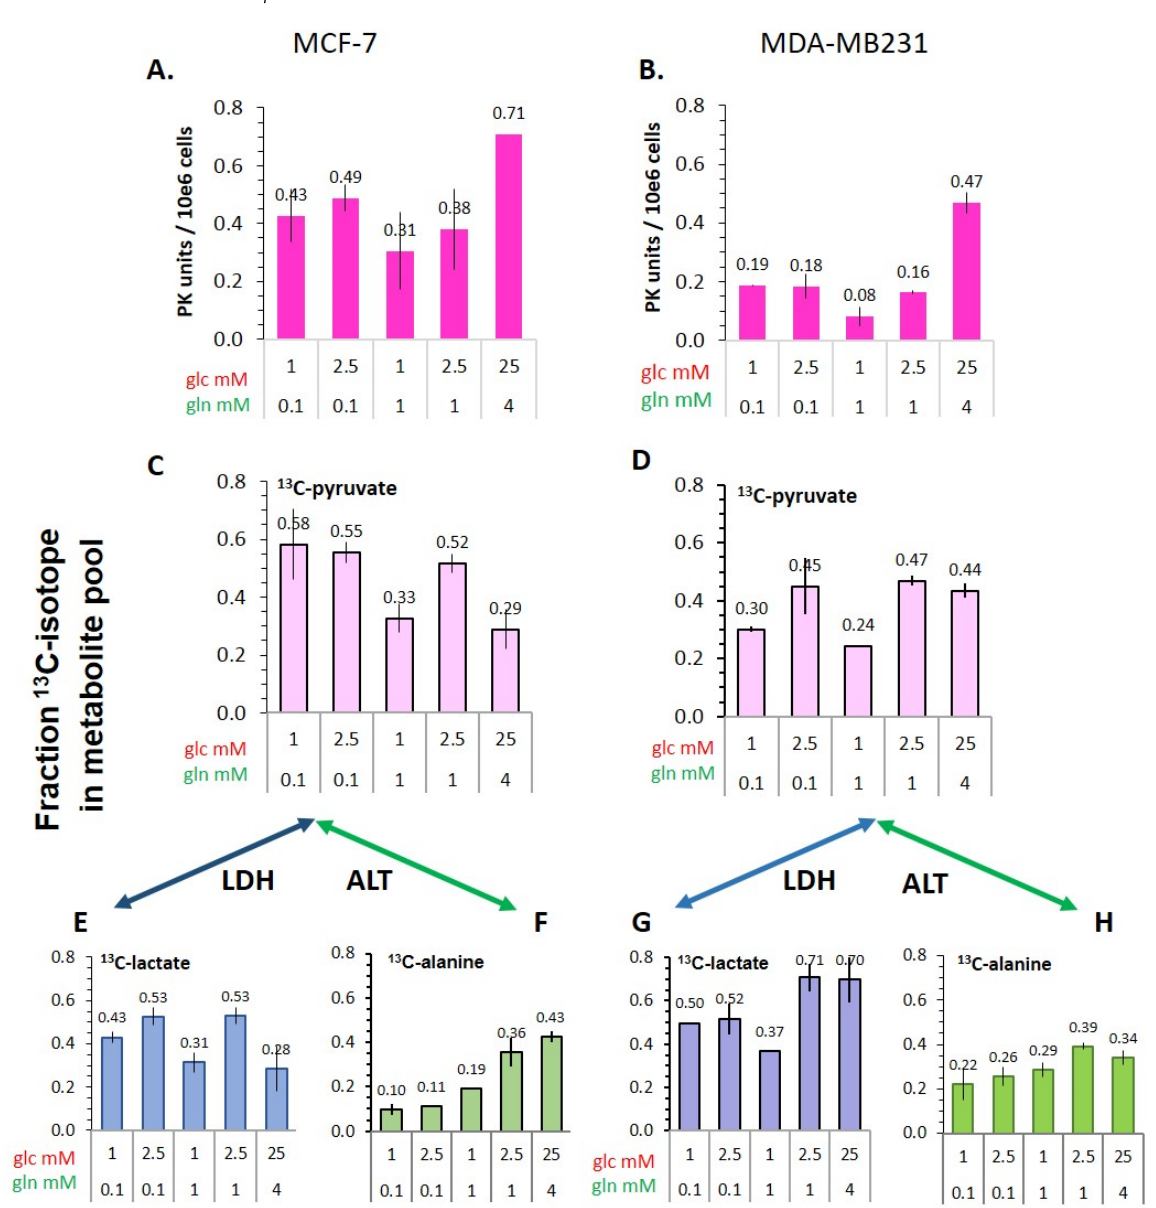
Figure 7. Glycolytic activity in different glucose/glutamine conditions as represented by pyruvate kinase activity and [U- 13 C 6 ]glucose-derived metabolite flux to 13 C-pyruvate and 13 C-lactate as well as 13 C-alanine in MCF-7 and MDA-MB-231 cells. ( A , B ) PK activity was determined in lysates from monolayer cultures of MCF-7 and MDA-MB-231 cells after 72 h in the indicated glucose/glutamine conditions. The enrichment of 13 C-pyruvate ( C , D ), 13 C-lactate ( E , G ), and 13 C-alanine ( F , H ) was determined following a 2 h incubation with the indicated 13 C 6 -glucose/glutamine concentrations of cells after their 72 h incubation in unlabeled glucose/glutamine conditions. Shown are averages with the s.e.m. from two independent experiments for each condition. For MCF-7 cells, the raw data from [39] were used.